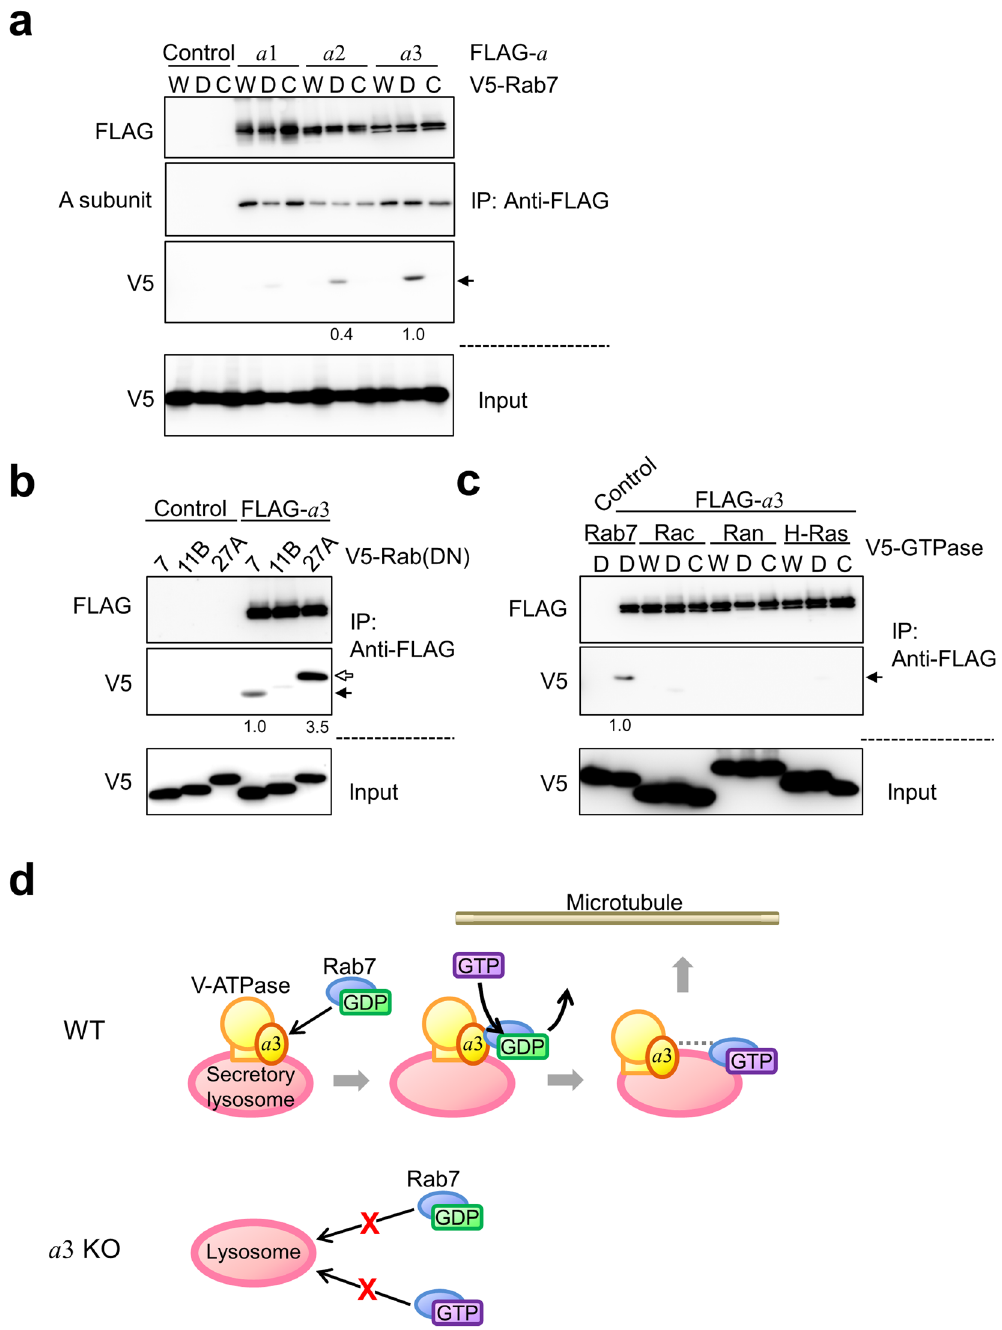
Figure 8. Interaction of a subunit isoforms with small GTP-binding proteins. ( a ) Interaction of a subunit isoforms and Rab7. FLAG-tagged a isoforms and various V5-fused forms of Rab7 were co-expressed in HEK293T cells. The cells were lysed, and lysates were immunoprecipitated with an anti-FLAG antibody. The precipitates were analysed using antibodies against FLAG (upper panel), the A subunit of the V 1 sector (upper middle panel) and V5 (lower middle panel). As a control, cells were co-transfected with an empty vector and a recombinant plasmid harbouring V5-fused Rab7 (Control). W, D and C indicate wild-type, dominant-negative GDP-bound (T22N) and constitutively active GTP-bound (Q67L) Rab7, respectively. About 5% of the cell lysate used for immunoprecipitation was also subjected to Western blotting with an anti-V5 antibody (lower panel). Dominant-negative Rab7 co-precipitated with FLAG- a 3 (middle panel, arrow). Numbers below blots represent relative signal intensities of V5-Rab7 co-precipitated with a isoform normalised to that co-precipitated with a 3. Relative intensities less than 0.1 are not shown. ( b ) Interaction of a 3 and dominant-negative Rab proteins. FLAG- a 3 and the V5-fused dominant-negative form of Rab7, Rab11B or Rab27A were co-expressed in HEK293T cells. Immunoprecipitation was carried out as described in ( a ). Rab7 and Rab27A were detected in the precipitate (middle panel, closed and open arrows, respectively). Numbers below blots represent relative signal intensities of V5-fused Rab protein co-precipitated with a 3 normalised to that of V5-Rab7.